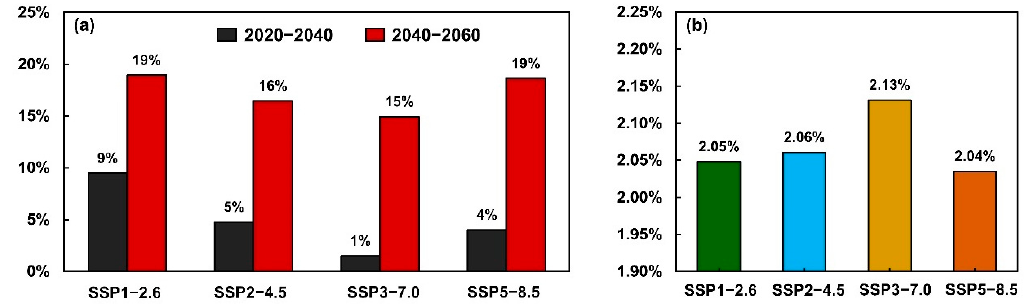
Figure 4. The change rate of the carbon sink capacity in 2040 and 2060 under different climate change scenarios compared with the average carbon sink capacity of the period of 2000–2020 ( a ); The change ratio of carbon sink capacity with management compared with that without management in 2060 under different climate change scenarios ( b ).